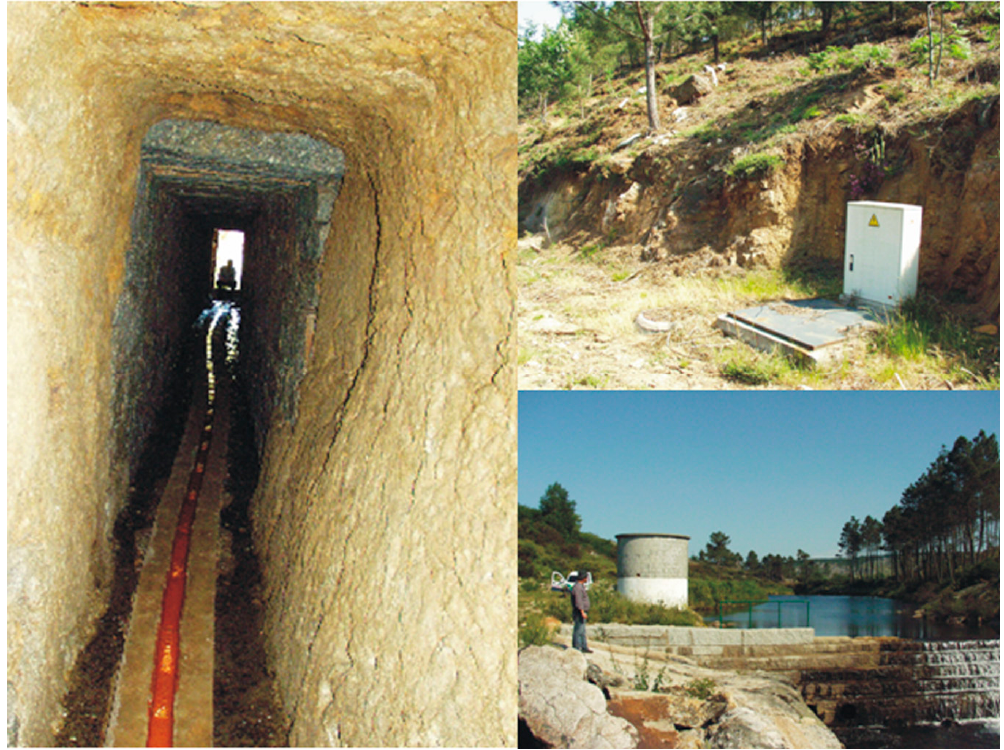
Figure 3. Sources of groundwater used in Vila Pouca de Aguiar for public supply of drinking water: left panel—spring/gallery; upper right panel—drilled well; lower right panel—alluvial well.